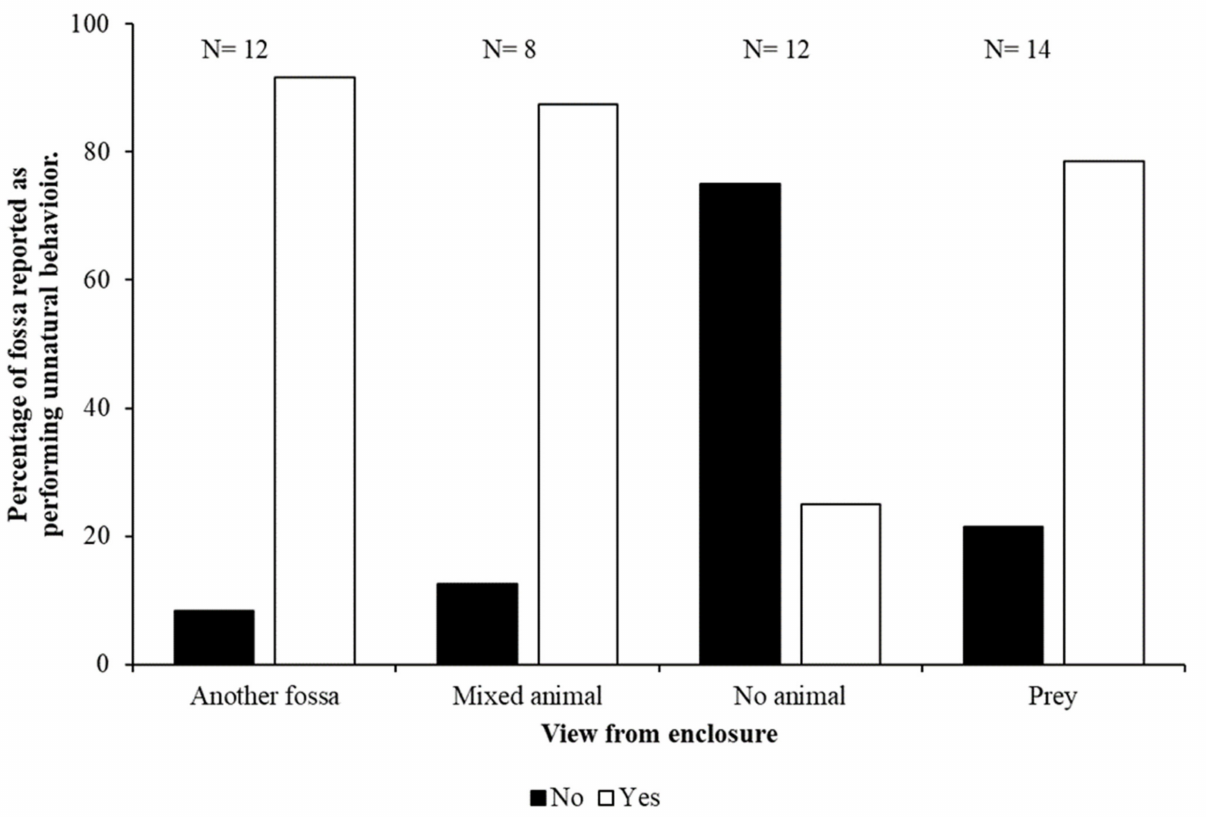
Figure 5. The view that each fossa had from its enclosure and the count of animals seen performing abnormal repetitive